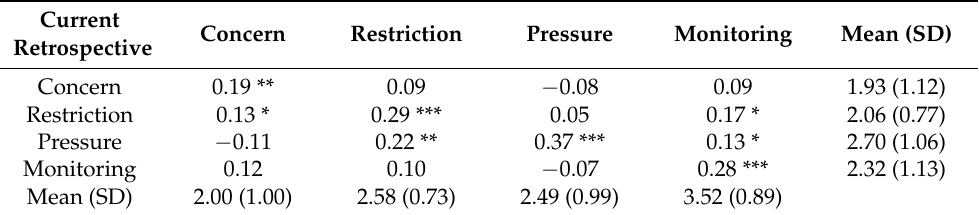
Table 1. Pearson correlations between retrospectively recalled maternal CFP and current CFP, after controlling for BMI; subscale means and SDs (N = 174).